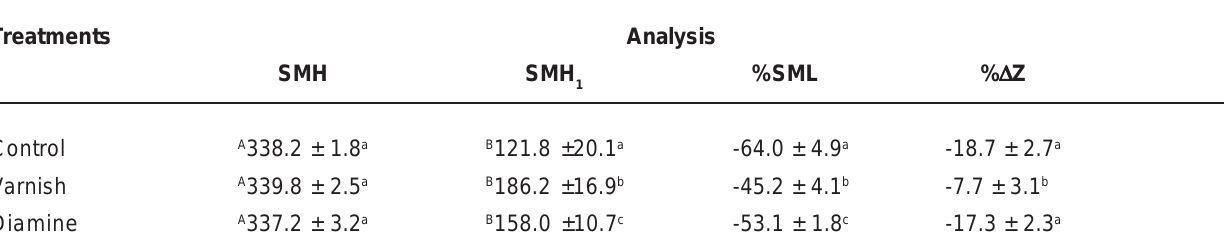
Mean values followed by different letters are statistically different at 5%. Capital letters show difference between SMH and SMH , and lower case letters among groups. SMH: initial surface microhardness. SMH 1